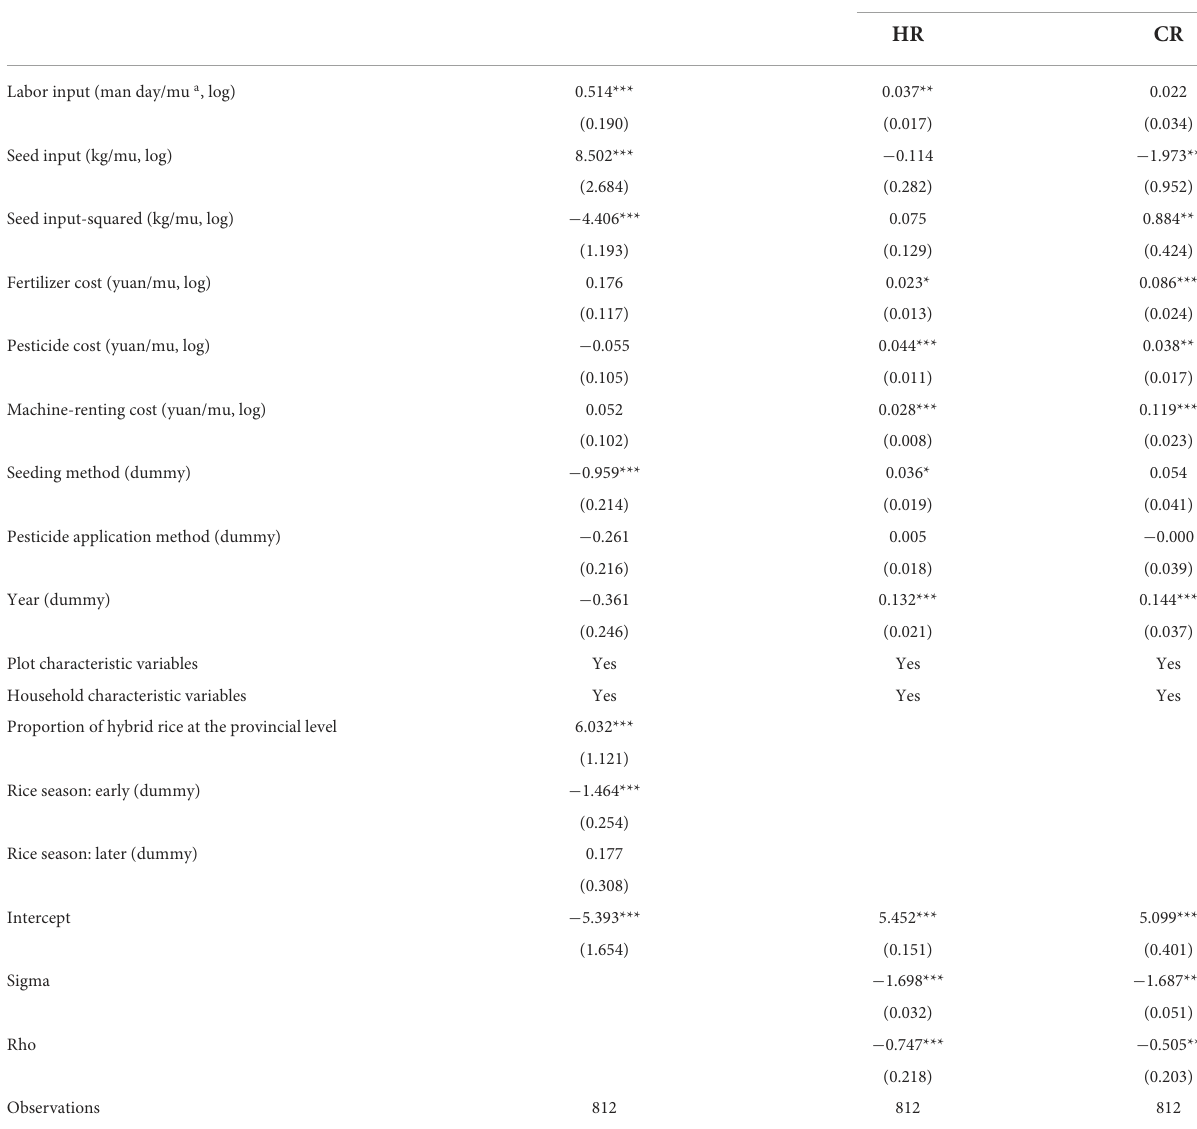
TABLE 2 ESR results for rice yield, China.